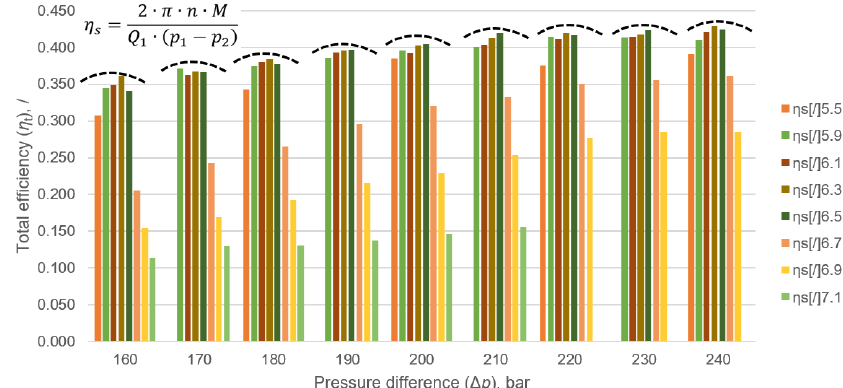
Figure 7. Total efficiency of hydraulic motor ( n = 15 min − 1 ).